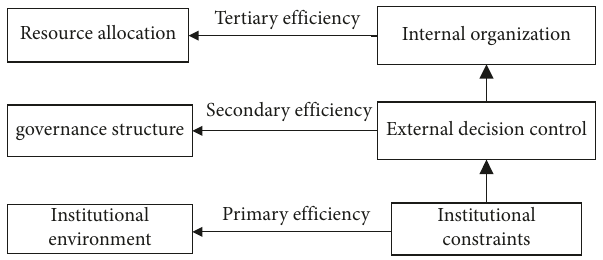
Figure 2: Configuration analysis block